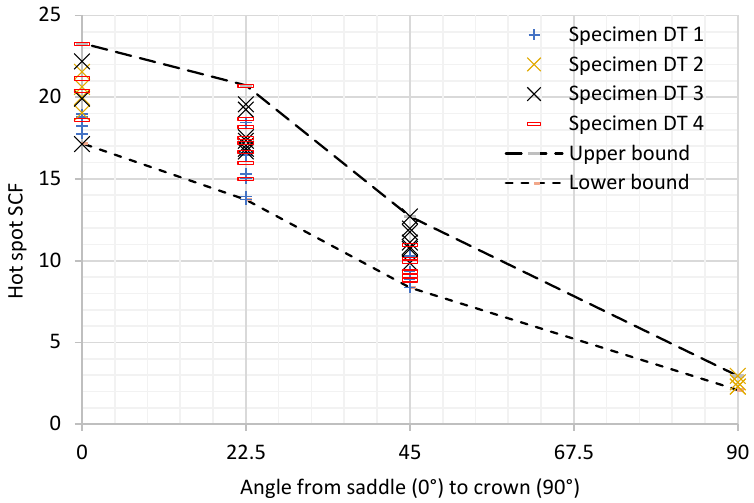
Figure 8. Experimental hot spot SCF along the weld toe from the saddle (0°) to crown (90°).